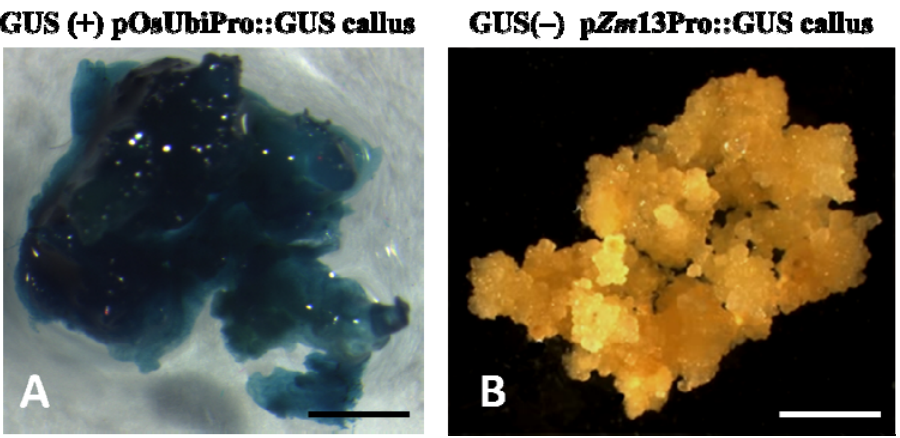
Figure 2. GUS activity in undifferentiated embryogenic callus. GUS activity in embryogenic hygromycin resistant callus transformed with ( A ) pOsUbiPro::GUS and ( B ) p Zm13 Pro::GUS. Scale bar = 0.3